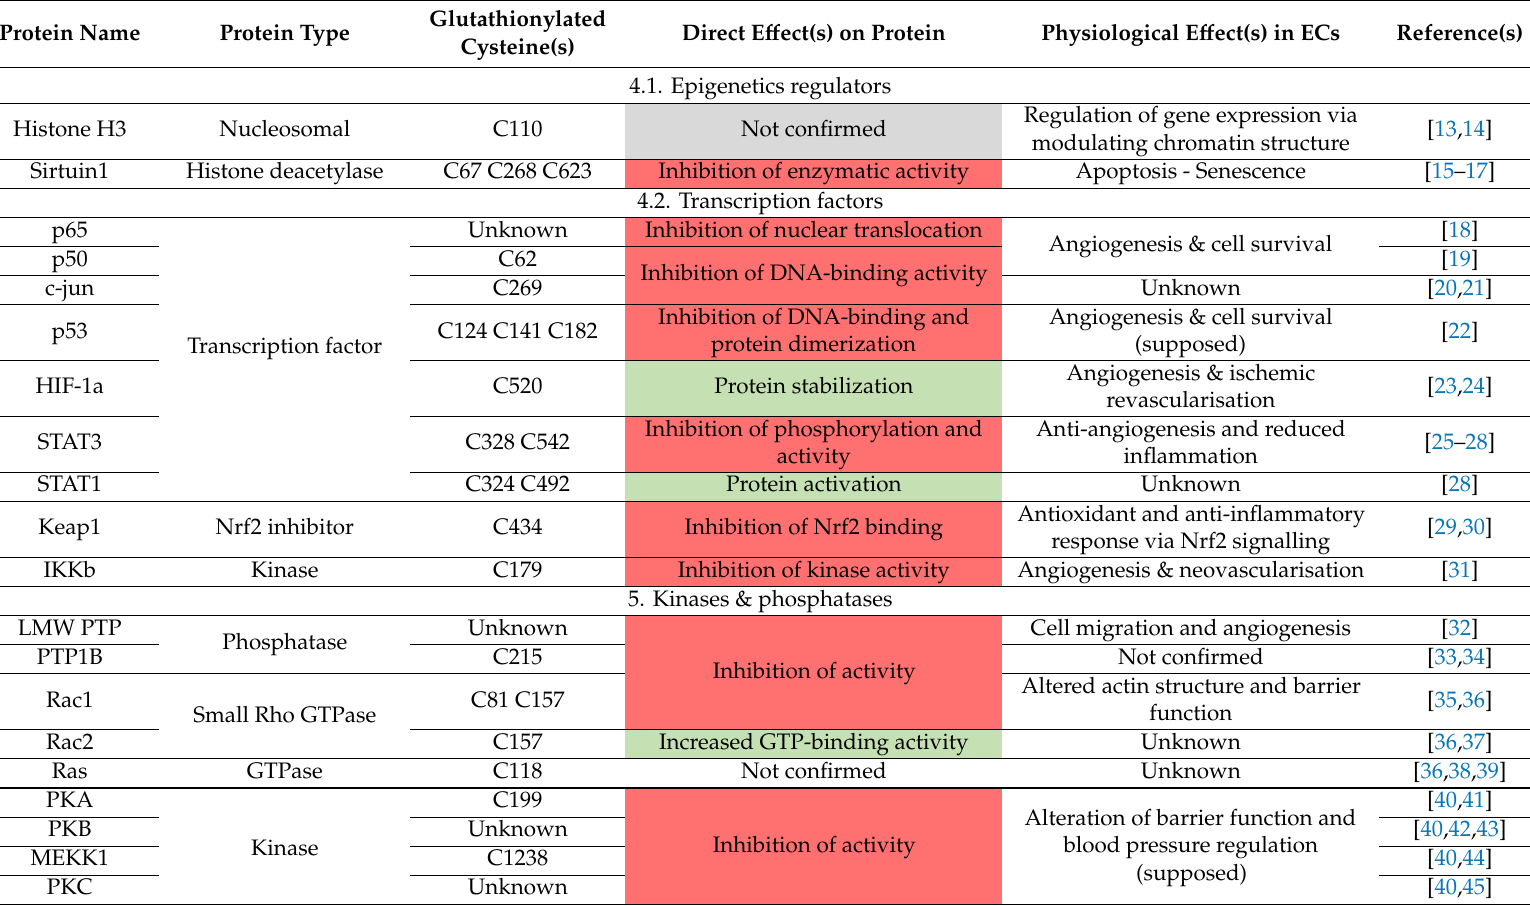
Table 1. Summary of S-glutathionylation activation (green) or inhibition (red) e ff ects on major molecular players in endothelial cell (EC) function and their physiological